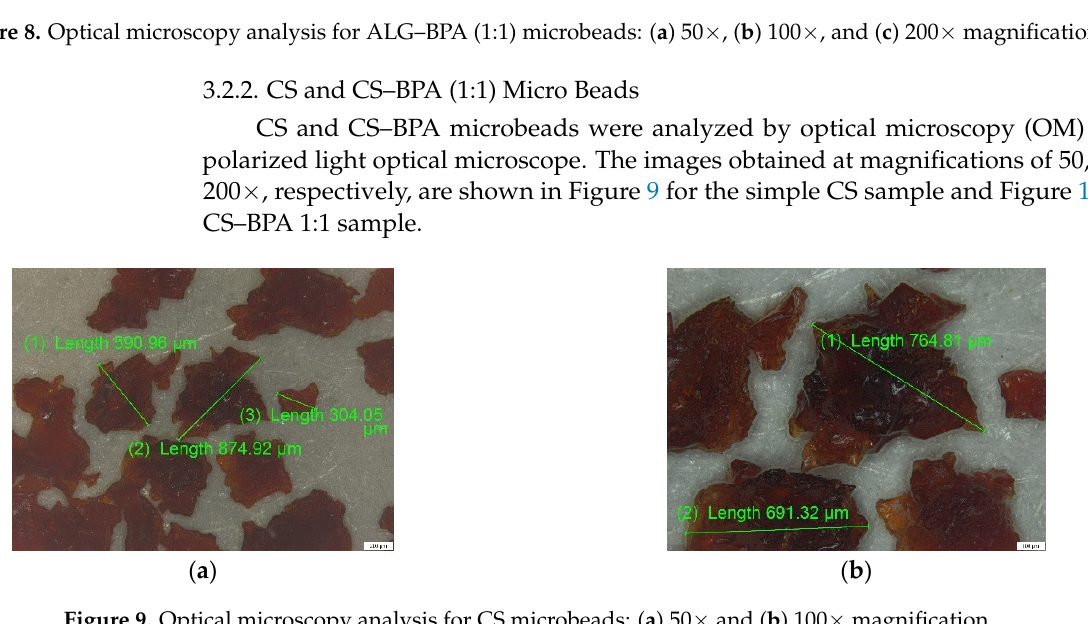
Figure 9. Optical microscopy analysis for CS microbeads: ( a ) 50× and ( b ) 100× magnification.